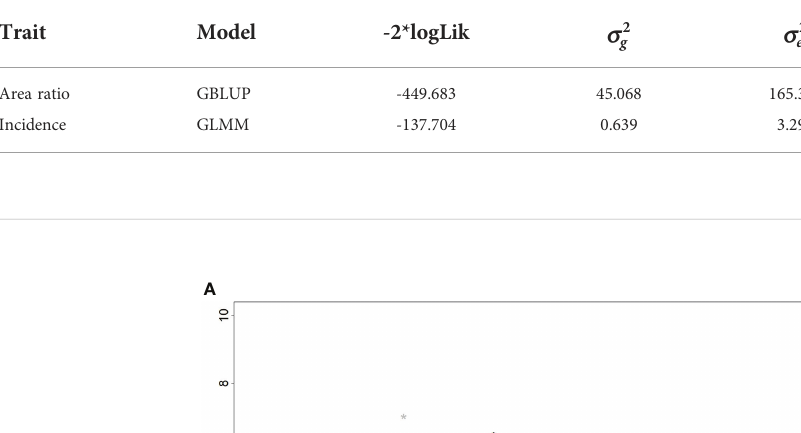
TABLE 2 variance component estimation and cross validation of hypermelanosis.